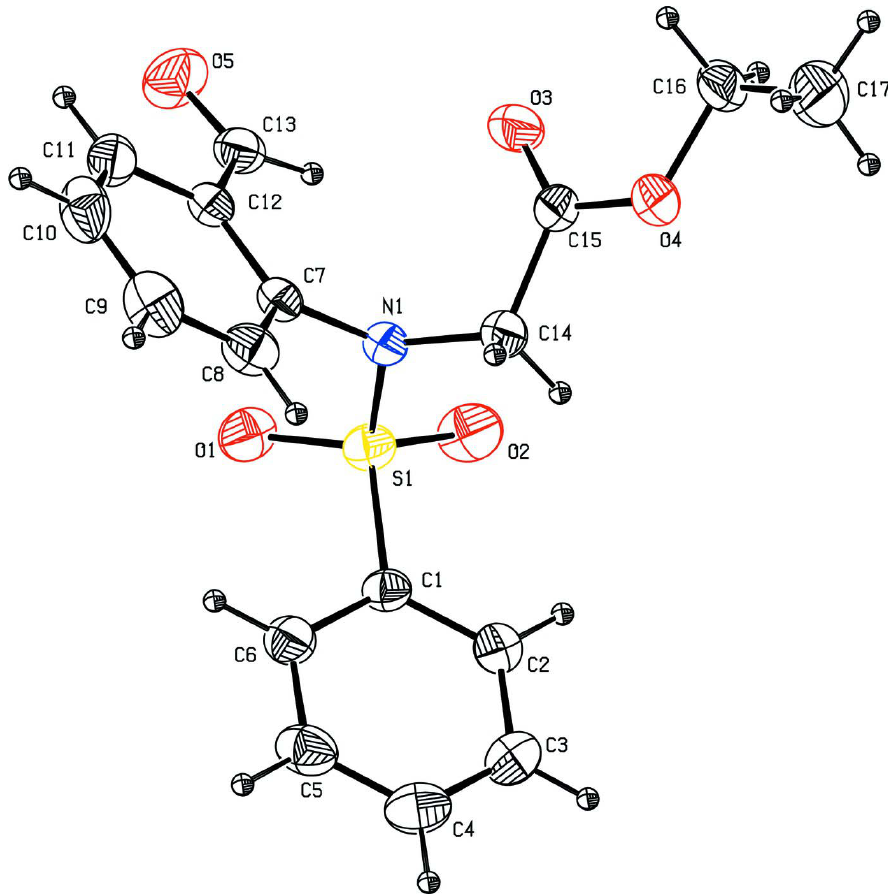
Figure 1 Molecular structure of the title compound, showing 30% probability displacement